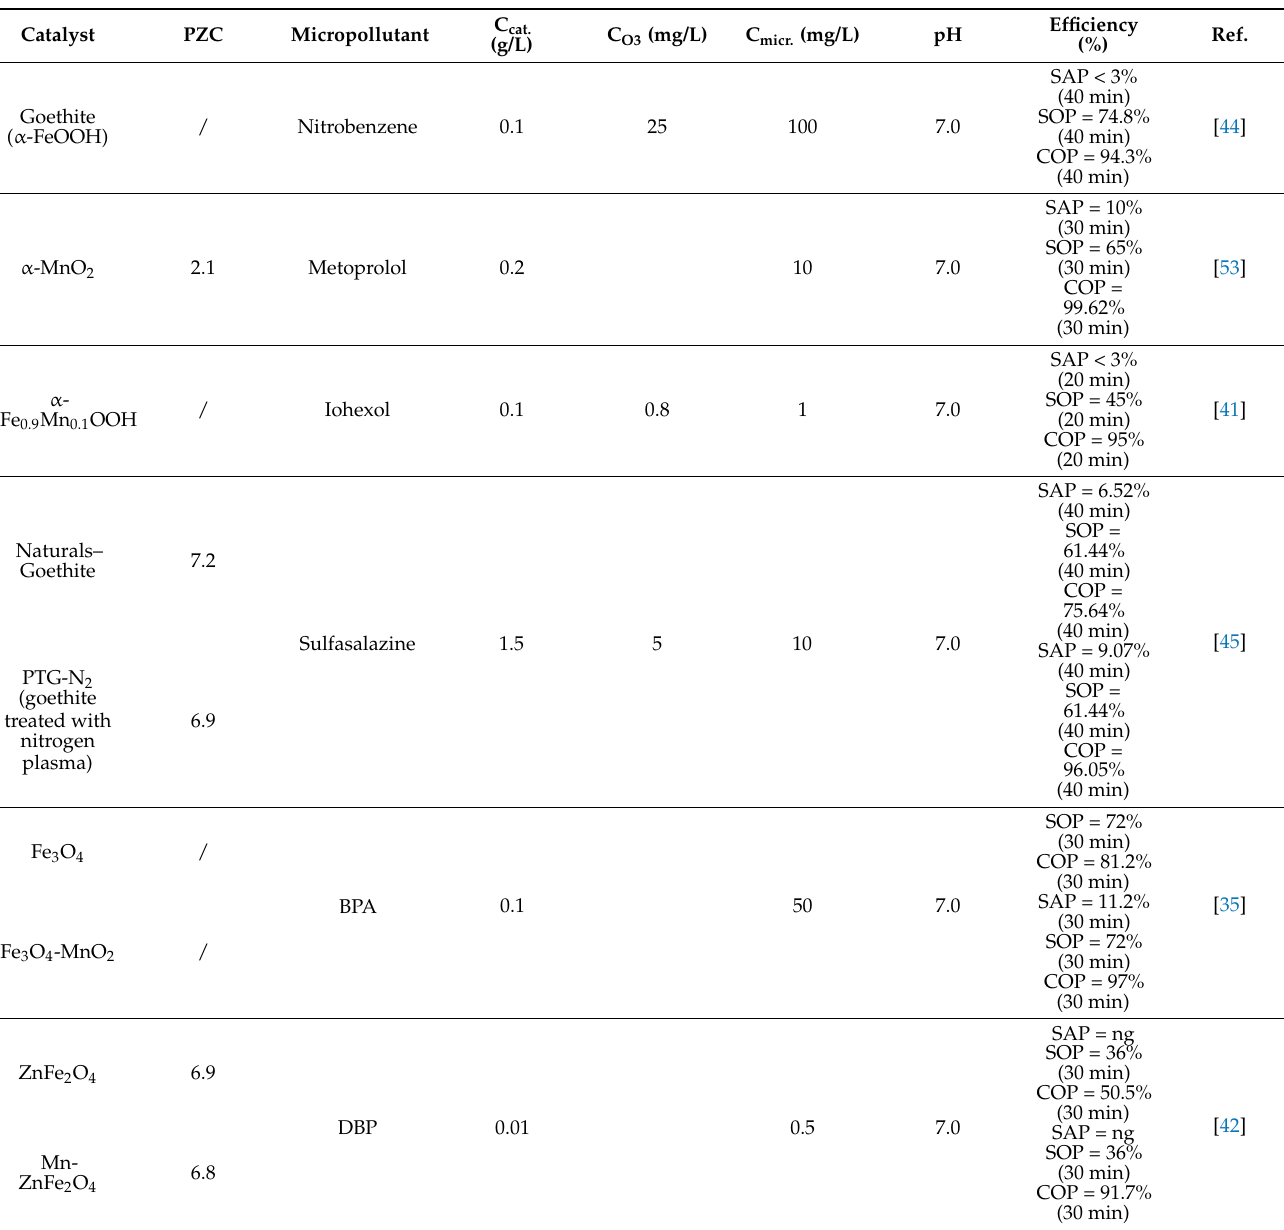
Table 1. Metal oxides as catalysts in the heterogeneous catalytic ozonation process for the removal of micropollutants at pH values